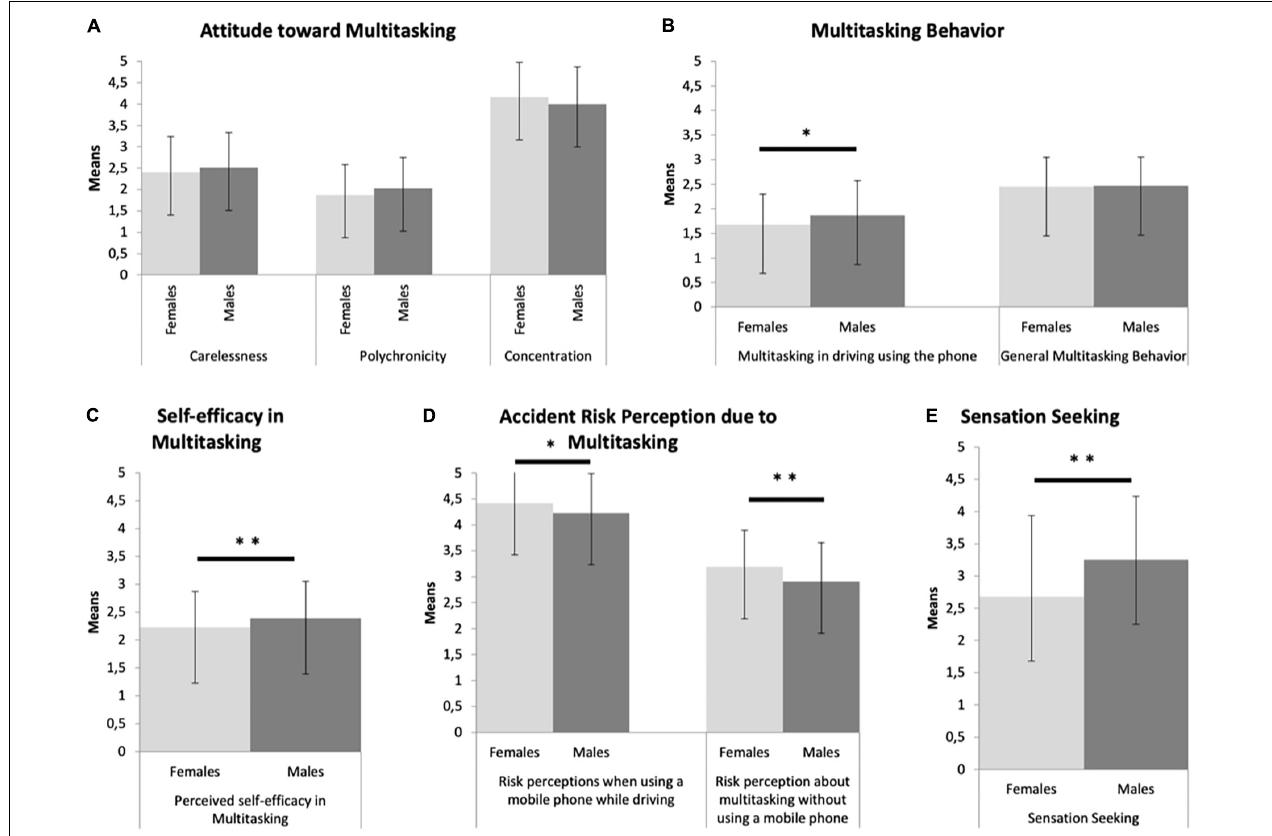
FIGURE 2 | Mean factor scores for the five dimensions [ (A) Attitude toward Multitasking; (B) Multitasking Behavior; (C) Self-efficacy in Multitasking; (D) Accident Risk Perception due to Multitasking; (E) Sensation-Seeking] represented for gender. ∗ p < 0.05, ∗∗ p <